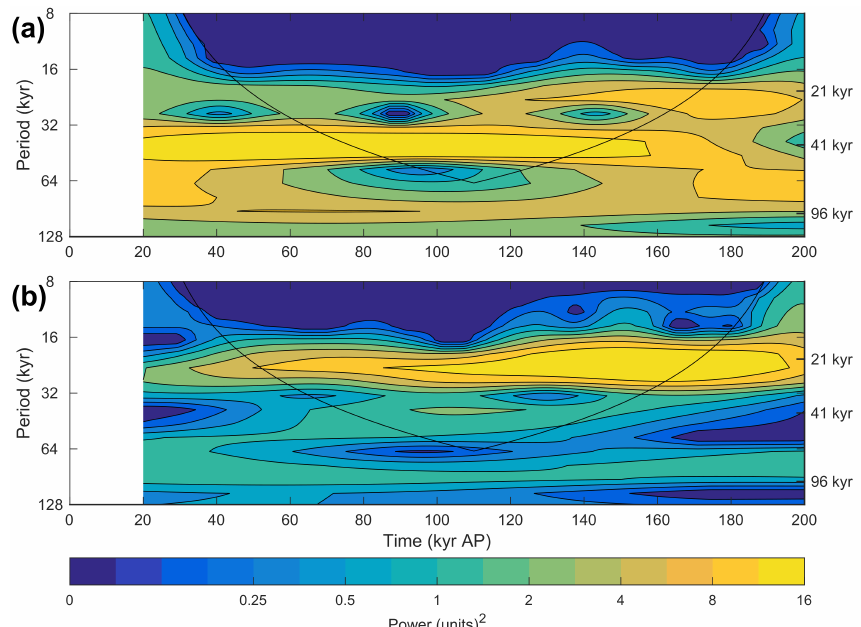
Figure 16. The wavelet power spectrum for the next 200kyr for the central England grid box. Wavelet analysis was performed on data for 20kyrAP onwards for (a) emulated grid box mean annual SAT ( ◦ C, blue line in Fig. 14c) and (b) emulated grid box mean annual precipitation (mmday − 1 , blue line in Fig. 15c). Both variables were modelled every 1kyr using the modice emulator for the 5000PgC emissions scenario. The data are normalised separately by (a) the mean variance for the analysed SAT data ( σ 2 = 0.14 ◦ C) and (b) the variance for the analysed precipitation data ( σ 2 = 0.003 ◦